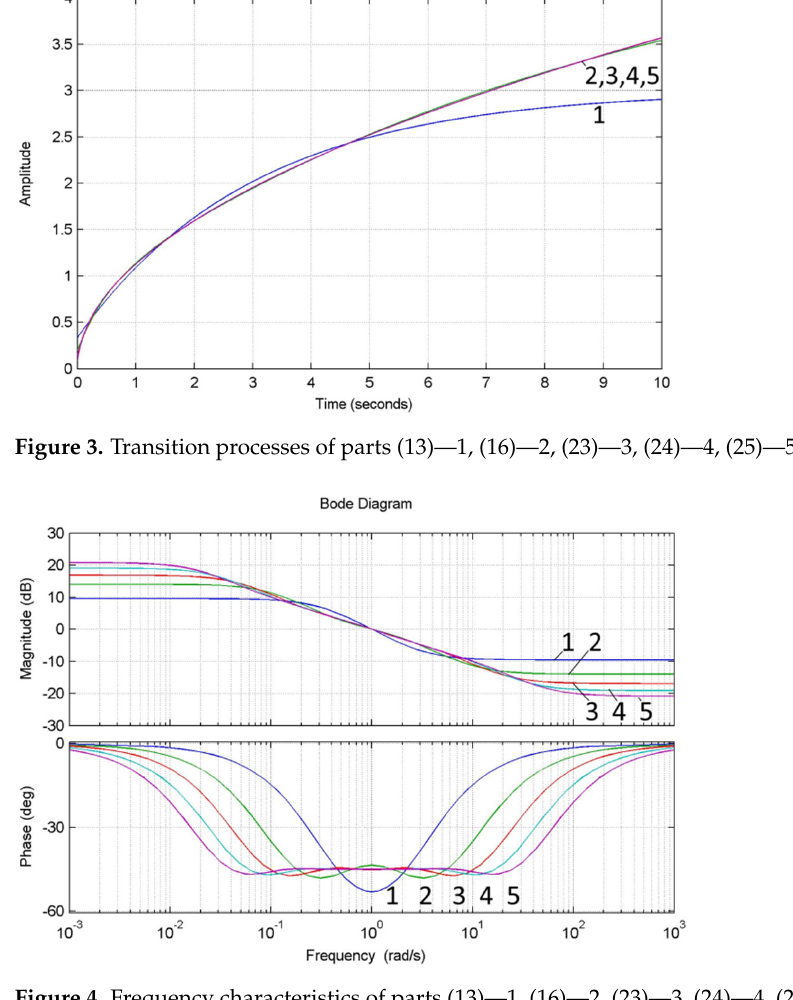
Figure 4. Frequency characteristics of parts (13)—1, (16)—2, (23)—3, (24)—4, (25)—5.